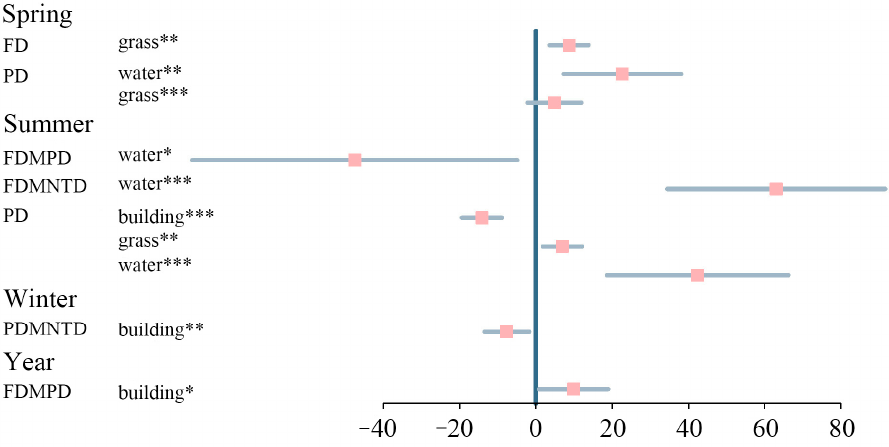
Figure 5. The average parameter estimates (standardized regression coefficients) of variables featured in the best models predicting bird diversities in different seasons (only significant variables are shown; for the others, see Table S1 in the Supplementary Materials). FD: functional diversity; PD: phylogenetic diversity; FDMPD: mean pairwise distance of functional diversity; FDMNTD: mean pairwise distance of functional diversity; PDMNTD: mean pairwise distance of phylogenetic diversity. The p -value of each independent variable is given as * < 0.05; ** < 0.01; *** < 0.001. For definitions of the abbreviations of the different variables, see Table 1.